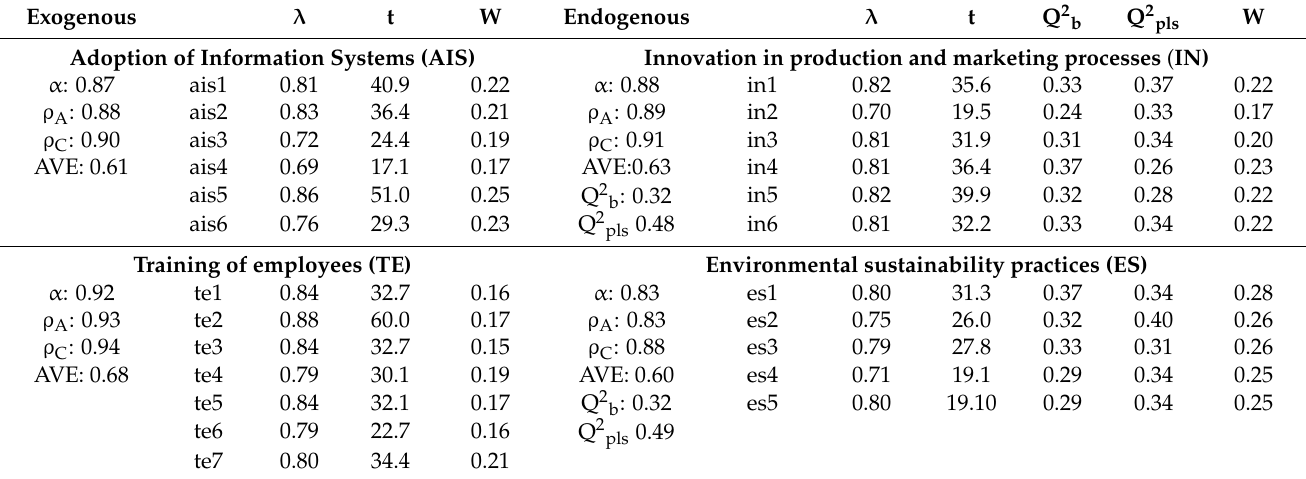
Table 3. Reliability and convergent